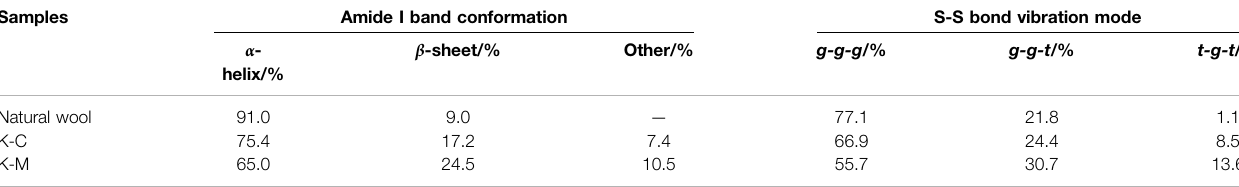
TABLE 3 | The integral area ratios of characteristic peaks in Raman spectra of samples. Samples Amide I band conformation